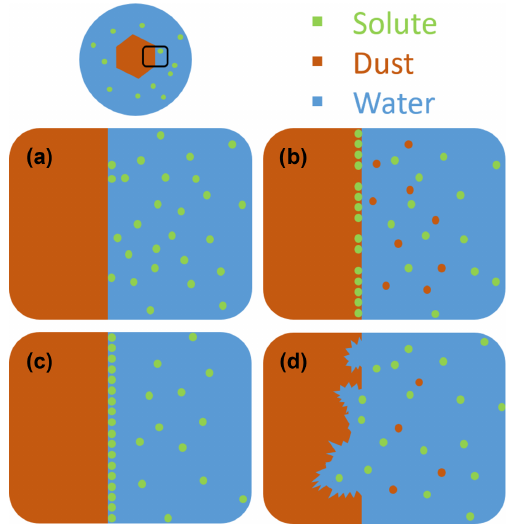
Figure 1. Schematic visualization of a mineral dust particle fully immersed in an aqueous solution droplet. Panels (a) to (d) de- pict different interactions of solutes on the mineral dust surface. (a) There is no specific interaction of the solute with the sur- face, which results in neither enrichment nor depletion of so- lute on the surface, and thus T het ( a w ) = T melt ( a w + (cid:49)a w , het ) with (cid:49)a w , het = const. (b) In the case of ionic solutes, cations located in the surface layer of the mineral can be exchanged with cations of the surrounding solution. (c) The solute adsorbs to the surface, leading to a surface enrichment and possibly coverage and blocking of IN-active sites. (d) Dissolution of the surface layer through re- active solutes (e.g., acids). Interactions depicted in panels (b) to (d) are characterized by (cid:49)a w ,, het (cid:54)= const and T het ( a w ) typically lower than expected from the (cid:49)a w criterion, i.e., a worsening of ice nu- cleation ability with increasing solute concentration, i.e., decreasing a w